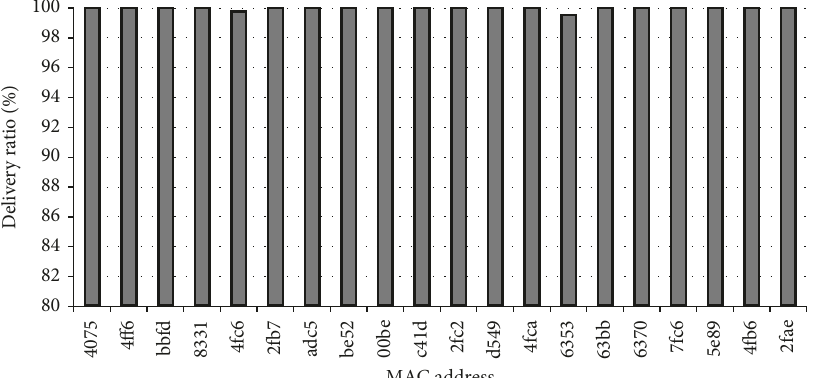
Figure 17: Delivery ratio performance with 20-node setup.